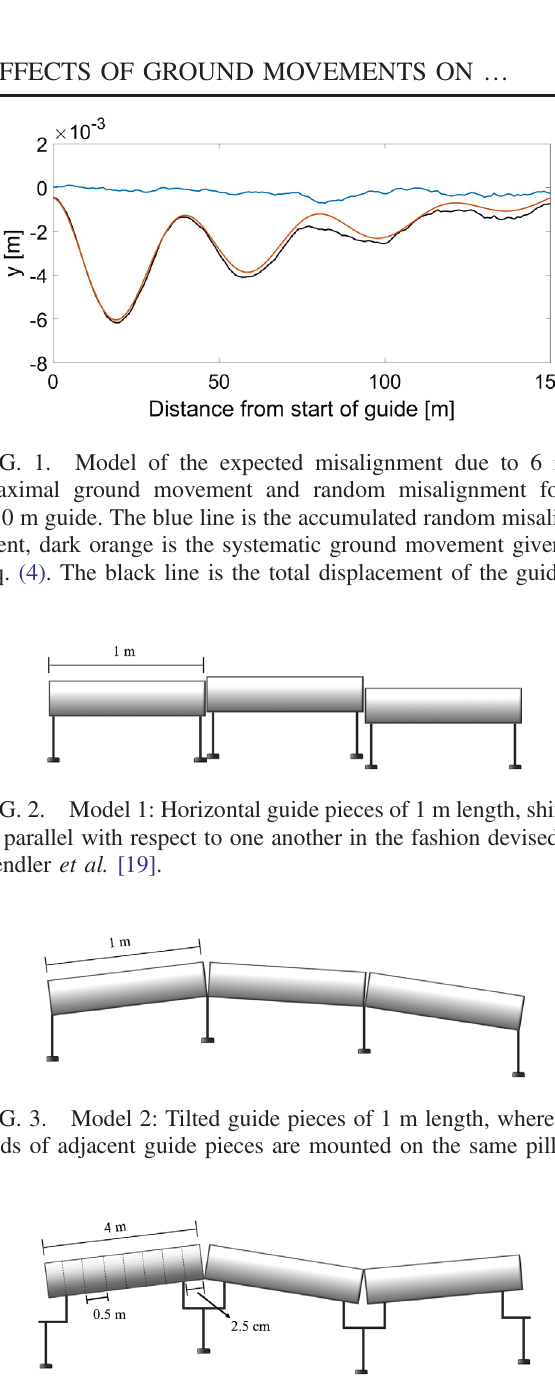
FIG. 4. Model 3: The construction-realistic guide model. Eight guide pieces of length 0.5 m are placed in a form and rest upon pillars. The resting point, referred to as the pivot point, is 2.5 cm from the edge of the Model 2. — 1 m long guide pieces are tilted around their starting points, as if two pieces are mounted at their corners to the same pillar. This closes the gaps, making the model more realistic. See Fig. 3.